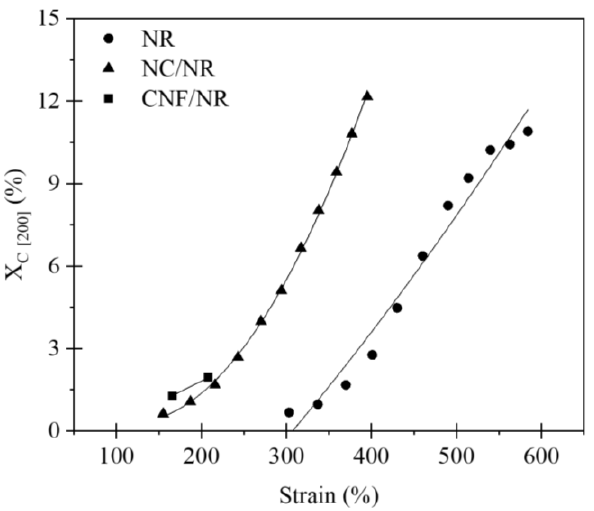
Figure 7. Variation of crystallinity ( X c ) as a function of applied strain for NR, NC/NR, and CNF/NR.